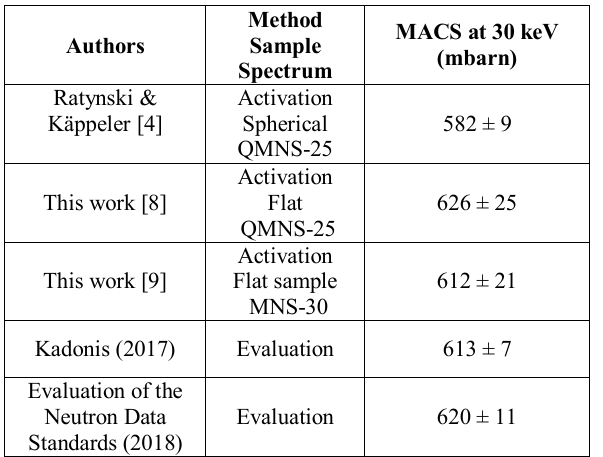
Table 2. Comparison of MACS values of 197 Au(n,  ) at kT=30